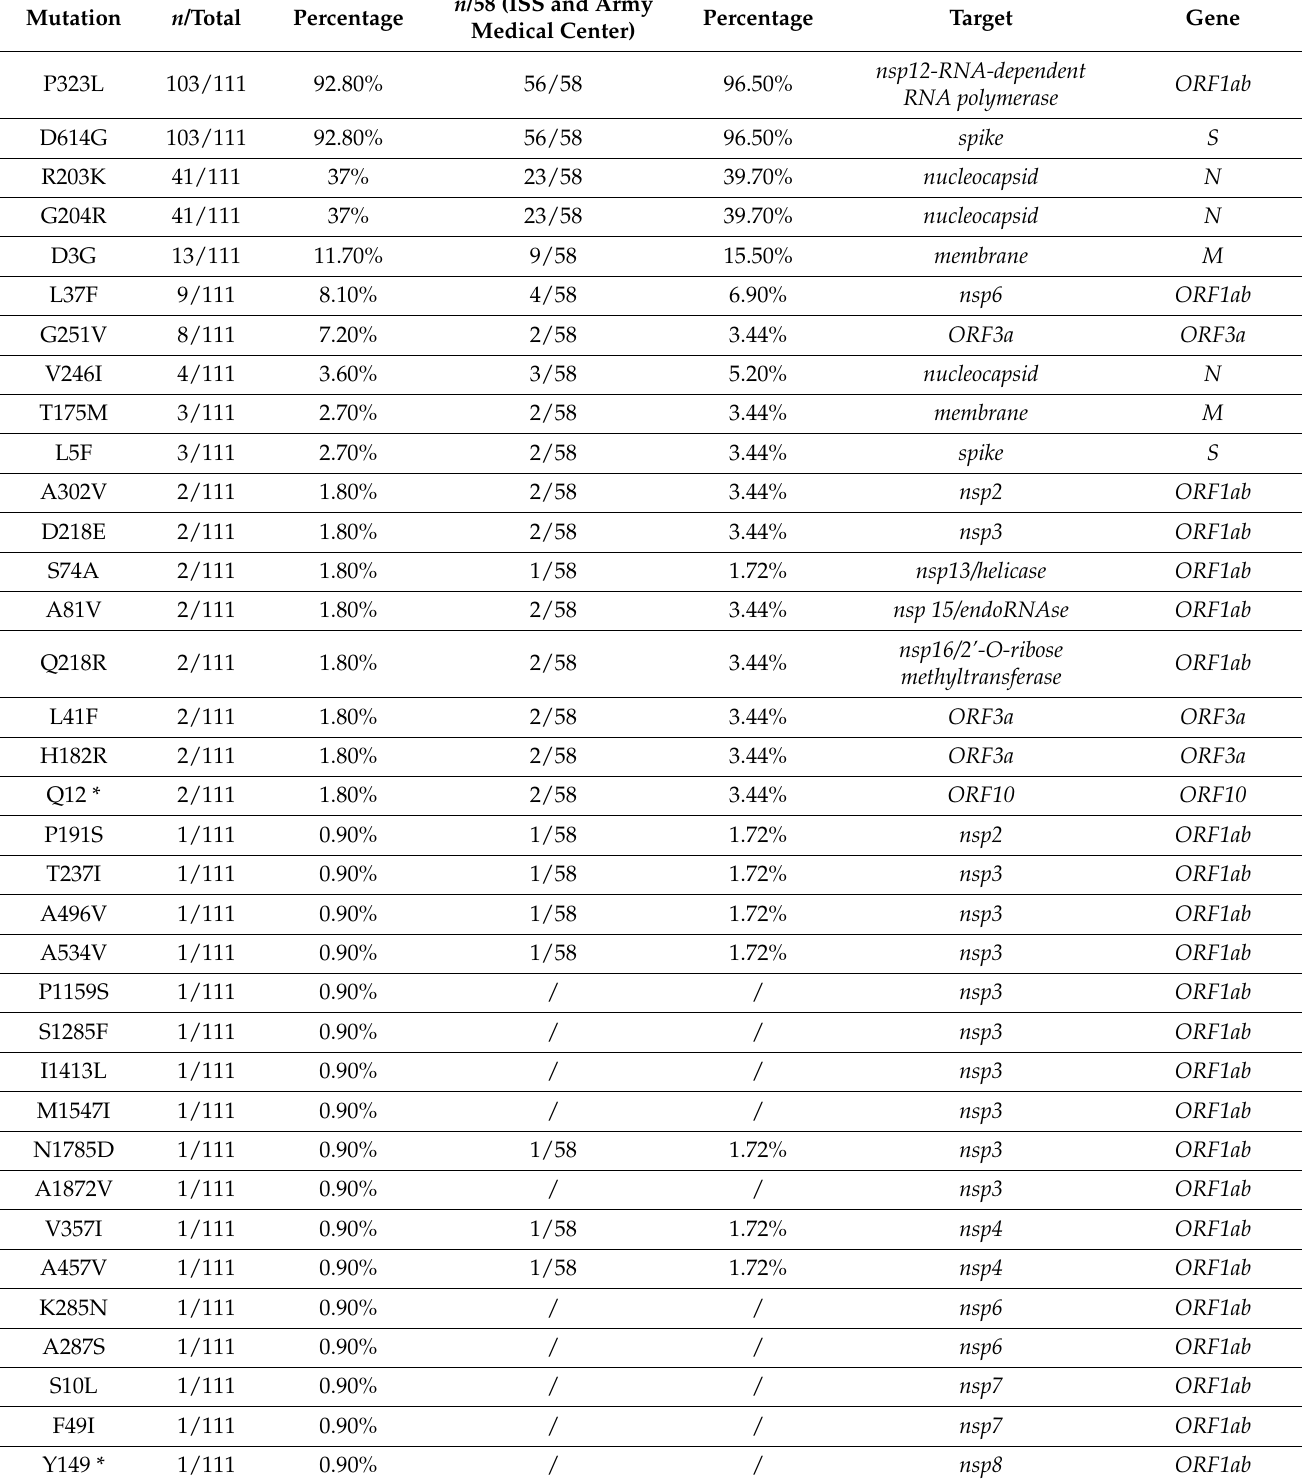
Table 2. The non-synonymous amino acid mutations harbored by the Italian genomes ( n = 111) investigated here and non-synonymous amino acid mutations harbored by the 58 Italian genomes collected from the Istituto Superiore di Sanit à and from the Italian Scientific Department of the Army Medical Center. The amino acids that resulted converted to a stop codon (*) are also